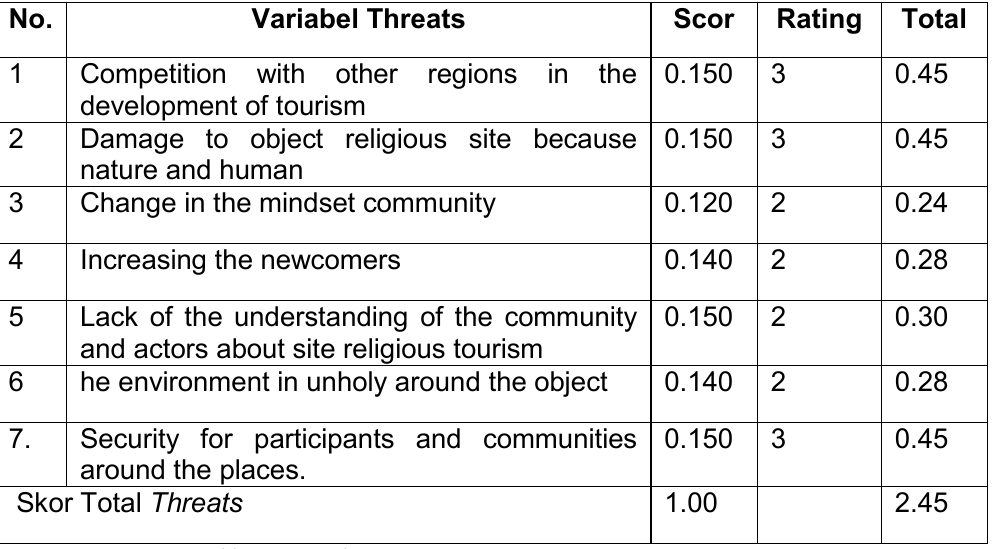
Table 4. Summary External Strategic Factor Analysis (EFAS) Threats